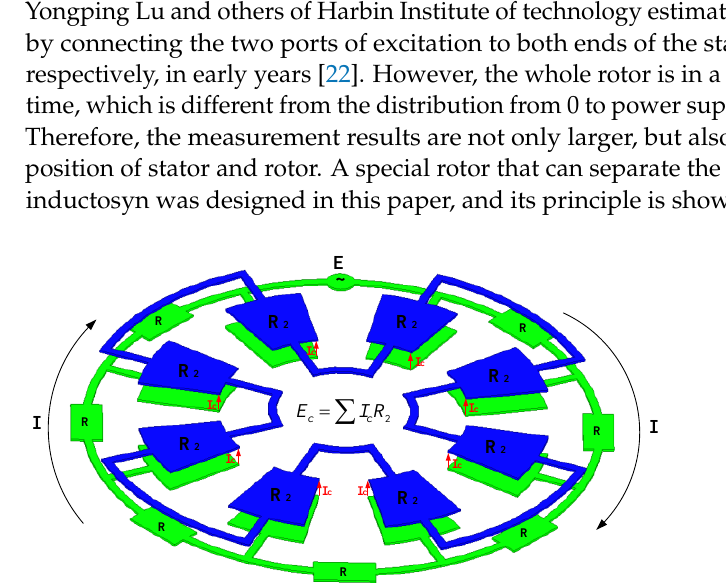
Figure 9. Extraction of capacitive potential in the inductosyn.